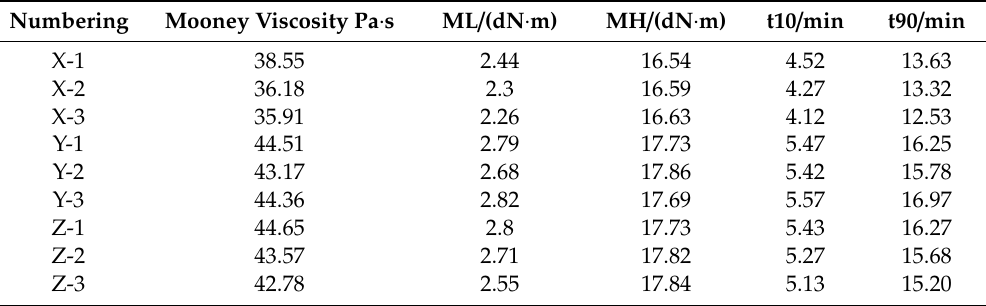
Table 5. Vulcanization characteristics of extruded products.